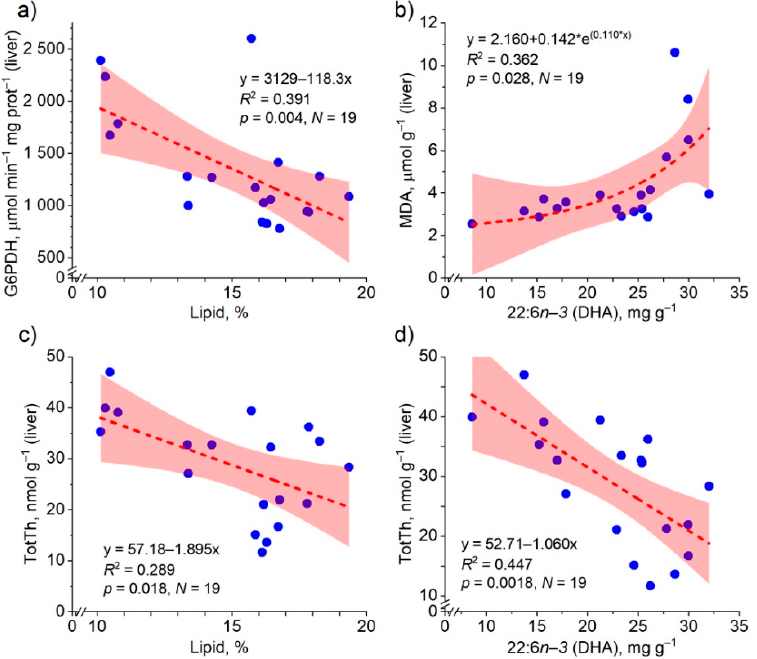
Figure 8. Relationships of the ( a ) hepatic glucose 6-phosphate dehydrogenase (G6PDH) activity with whole-body lipid content, ( b ) hepatic malondialdehyde (MDA) with docosahexaenoic acid (22:6 n − 3 , DHA) concentration, ( c ) hepatic total thiamine (TotTh) concentration with whole-body lipid content, and ( d ) hepatic TotTh concentration with DHA concentration of salmon ( Salmo salar ) from the Baltic Proper, Bothnian Sea, and Gulf of Finland. The fitting of the linear models with 95% confidence bands, coefficients of determination ( R 2 ), significances ( p ) of the model, and the number of samples are given.